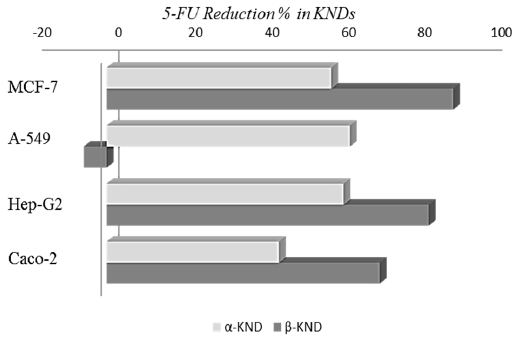
Figure 11. 5-FU reduction percentage in KNDs in MCF-7, A549, Hep-G2, and Caco-2 cells at 72 h of exposure to induce the 50% of cellular growth inhibition.